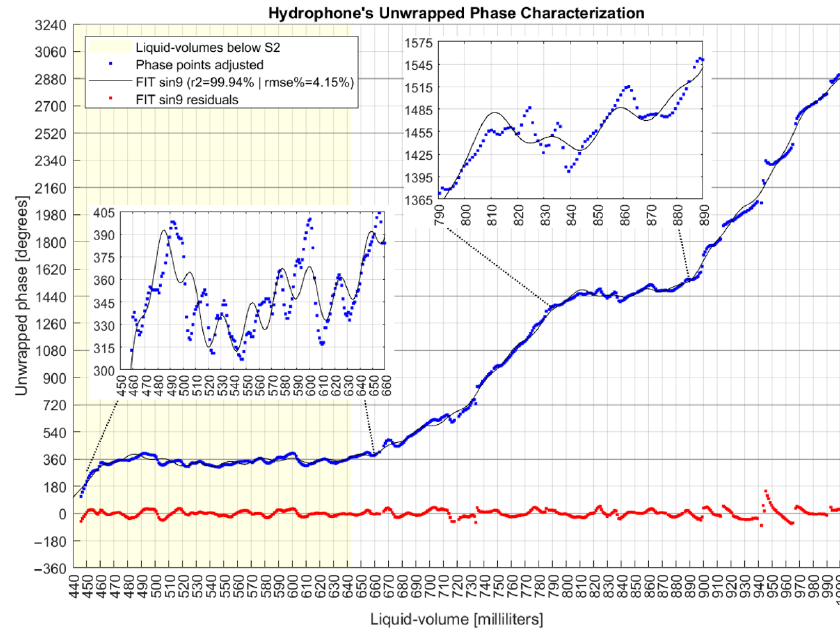
Figure 13. Hydrophone system’s unwrapped phase characterization.